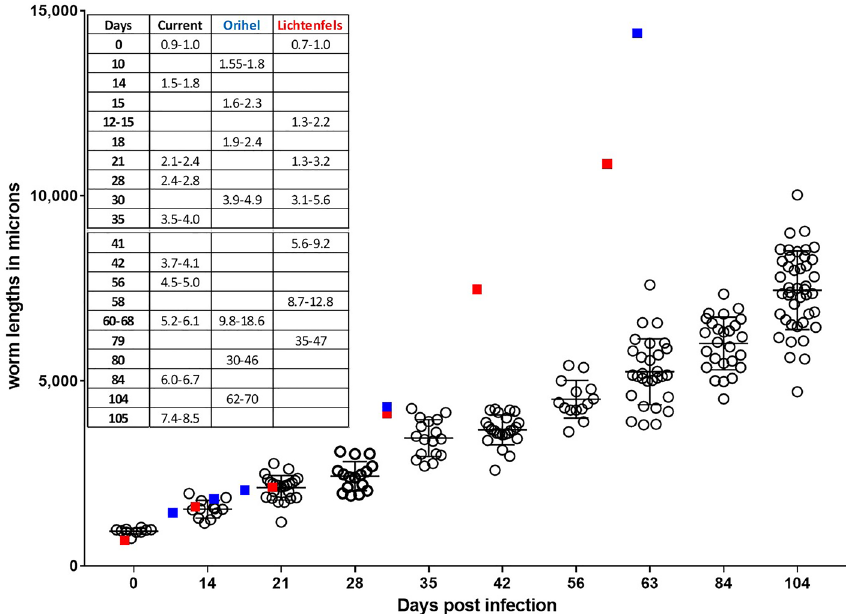
Figure 1. Growth curve for larva of Dirofilaria immitis injected subcutaneously into NSG mice. Fifty L3 were injected, and parasites were recovered at various time points over 105 days. Table insert presents the range of sizes of parasites, for comparative purposes, recovered in the present study (current) and from two studies in which parasites were recovered from dogs, Orihel 9 and Lichtenfels 8 . Blue squares denote approximate size of worms recovered from the Orihel study and red squares approximate size of worms recovered from the Lichtenfels